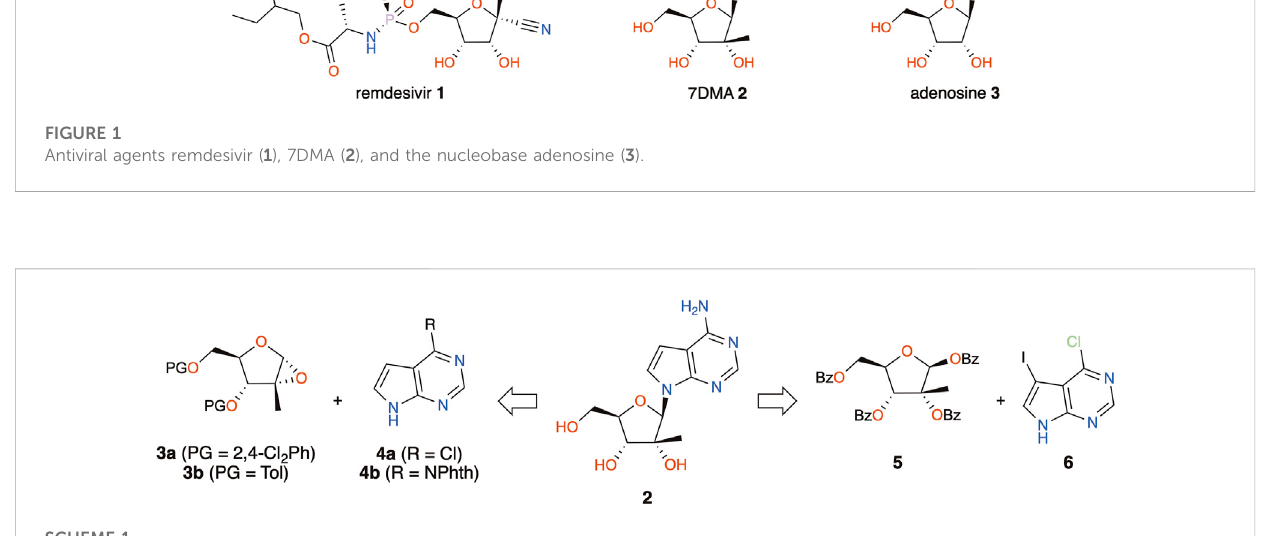
SCHEME 1 Previous and proposed synthetic routes toward 7DMA ( 2